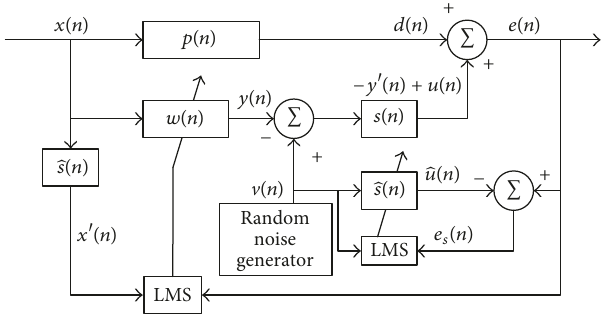
Figure 1: Eriksson’s method with online error channel identifica-